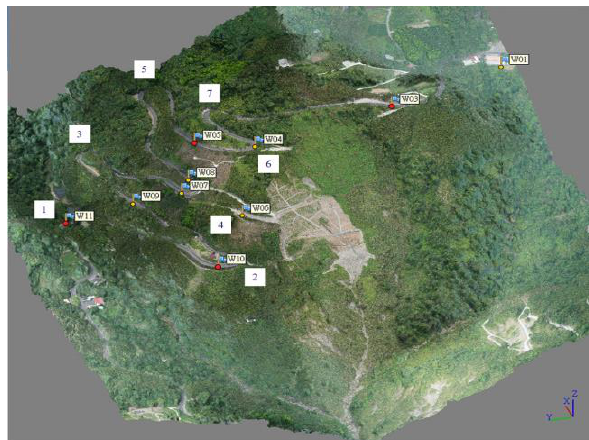
Figure 1. WuWanZai in 3D view with the location of GCPs/CKPs together with road curve